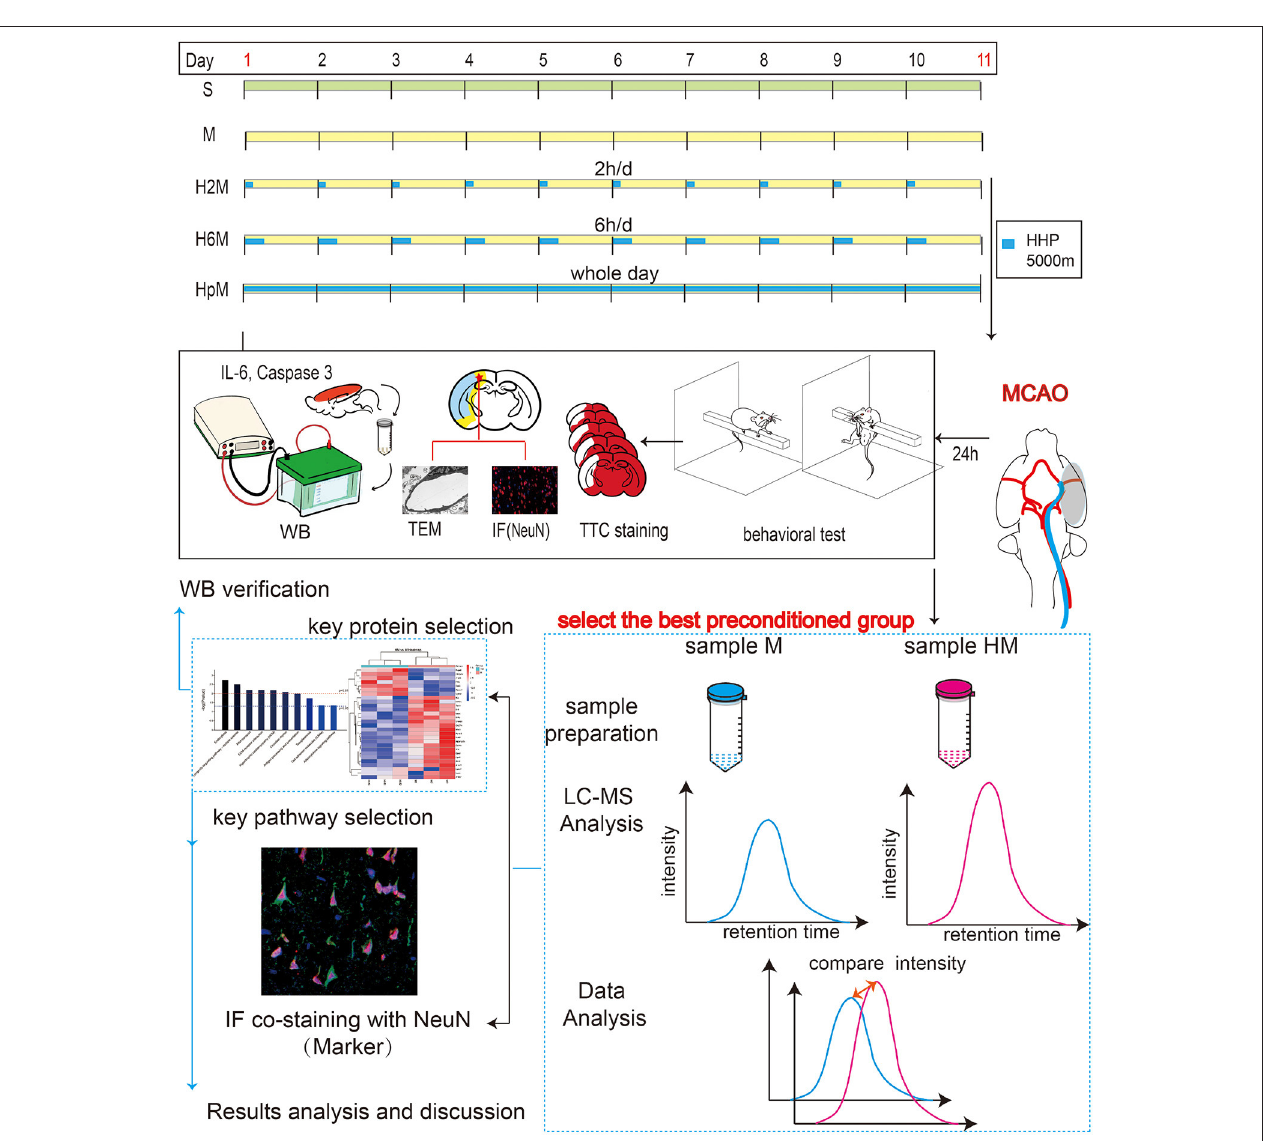
FIGURE 1 | Experimental workflow. One hundred four rats were randomly divided into five groups: group S (sham, n = 20), group M (middle cerebral artery occlusion [MCAO], n = 28), group H2M (intermittent hypobaric hypoxia preconditioned MCAO group, 2 h/day, n = 20), group H6M (intermittent hypobaric hypoxia preconditioned MCAO group, 6 h/day, n = 28), and group HpM (persistent hypobaric hypoxia preconditioned MCAO group, n = 28). Behavioral tests and morphological staining (TTC staining) were used to analyze the severity of infarction. Total protein expression of NeuN (a specific marker of mature neurons), caspase-3, cleaved-caspase-3, and IL-6 was estimated using western blotting, which explained the severity of injury from different perspectives. Ultrastructural changes were observed under a transmission electron microscope. The most effective pretreatment group was selected for further label-free proteomic study and provided a reliable direction for mechanism exploration. Western blotting was used to verify the expression of the target protein, and key markers for the biological process were detected using immunofluorescence. caspase-3, cysteinyl aspartate specific proteinase 3; IL-6, interleukin 6; NeuN, neuron-specific nuclear protein; TTC, 2,3,5-triphenyl tetrazolium